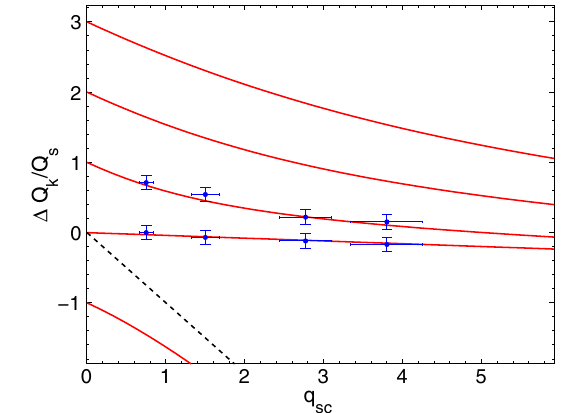
FIG. 14. This plot shows the predicted shifts from analytical Eq. (8) and measured head-tail mode frequencies are overlaid in the horizontal plane for N 7 þ ion beam at various current levels (Table II).